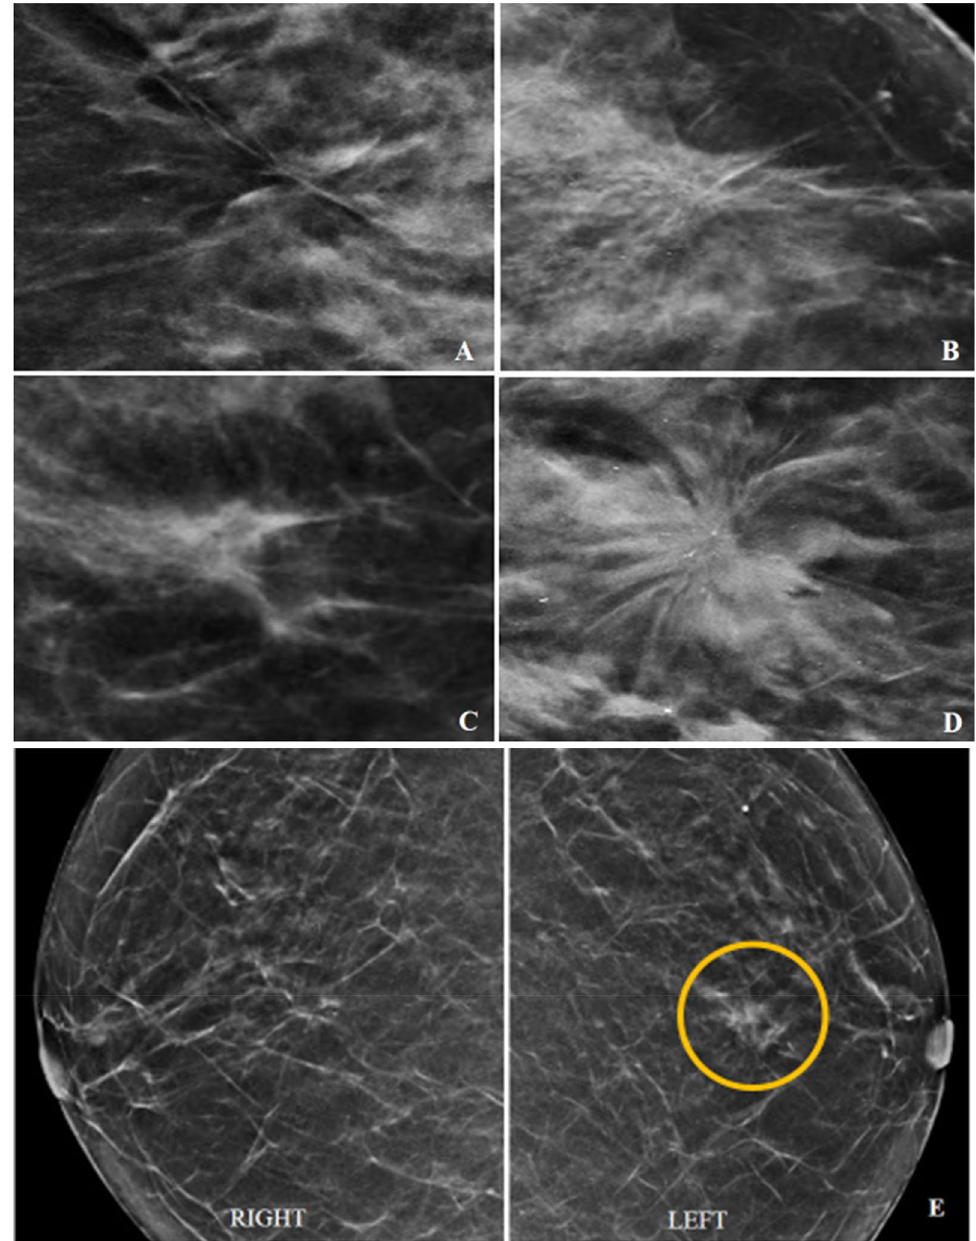
Figure 2. ( A–E ) showing architectural distortion ( A , B ) and spiculated density ( C , D ) with their respective HPE (benign vs malignant). Architectural distortion – no malignancy ( A ) and low-grade DCIS ( B ). Spiculated mass—periductal mastitis ( C ) and invasive ductal carcinoma ( D ). Figure E showing asymmetrical density (yellow circle) in the left breast in comparison with the right breast – no